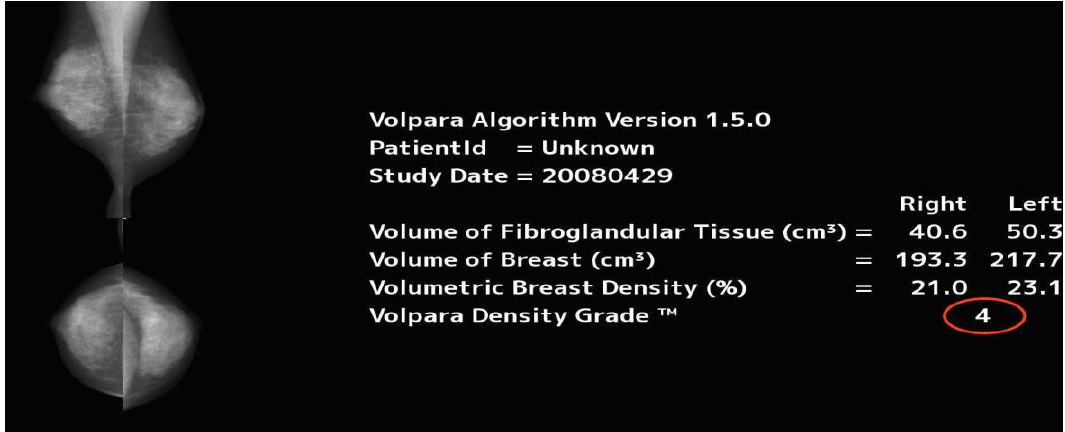
Figure 3. Screen shot of an example of the automated objective density assessment (VOLPARA) software; the red circle shows the BI-RADS as graded by the software.